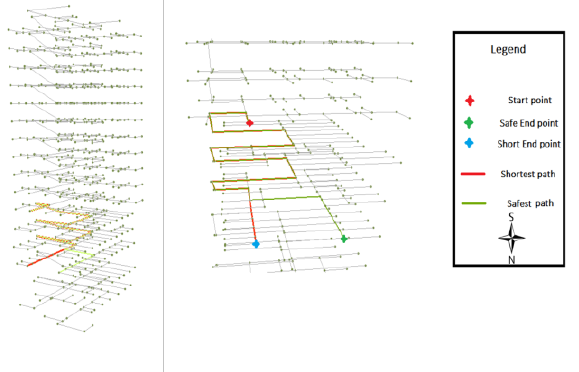
Figure 11. Scenario No. 5- The shortest and safest paths